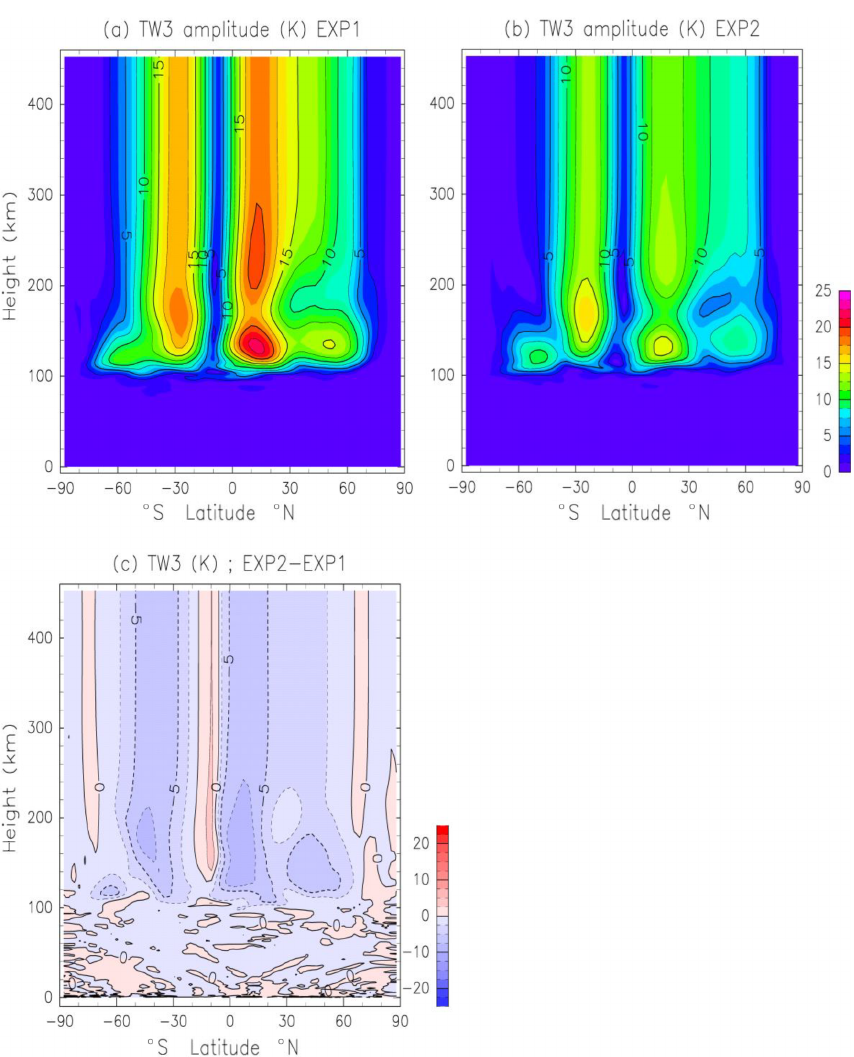
Figure 6. (a) Temperature component of the TW3 amplitude in June obtained by EXP1. Units are kelvins. Contour intervals are 5K. (b) As in (a) except for EXP2. (c) Temperature difference between EXP1 and EXP2 (EXP2–EXP1). Contour intervals are